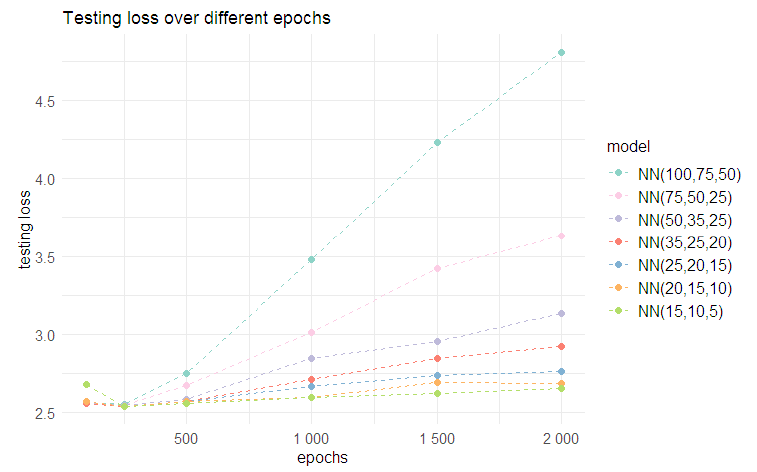
Figure 7. Change in the testing (out-of-sample) loss for Poisson neural network models with different architectures as epochs increase.